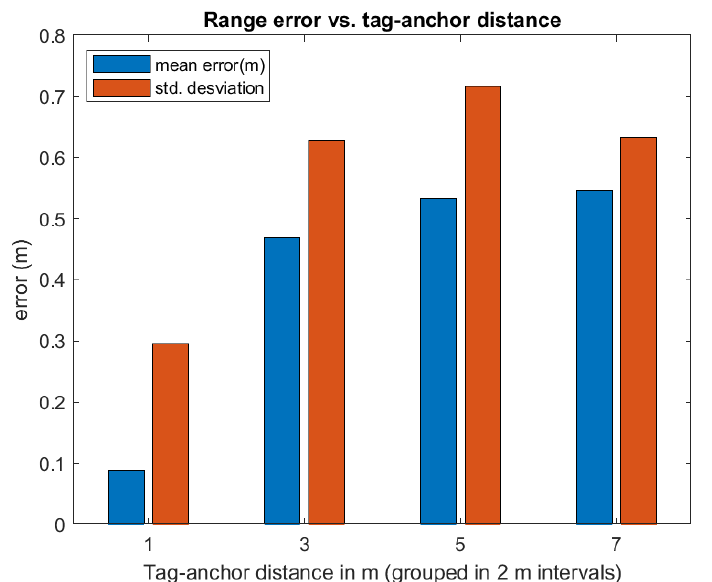
Figure 21. Mean and standard deviation of the measured range error in four groups of range bins: 0–2 m, 2–4 m, 4–6 m, and 6-Infinite. Information is obtained from the same data as in Figures 19 and